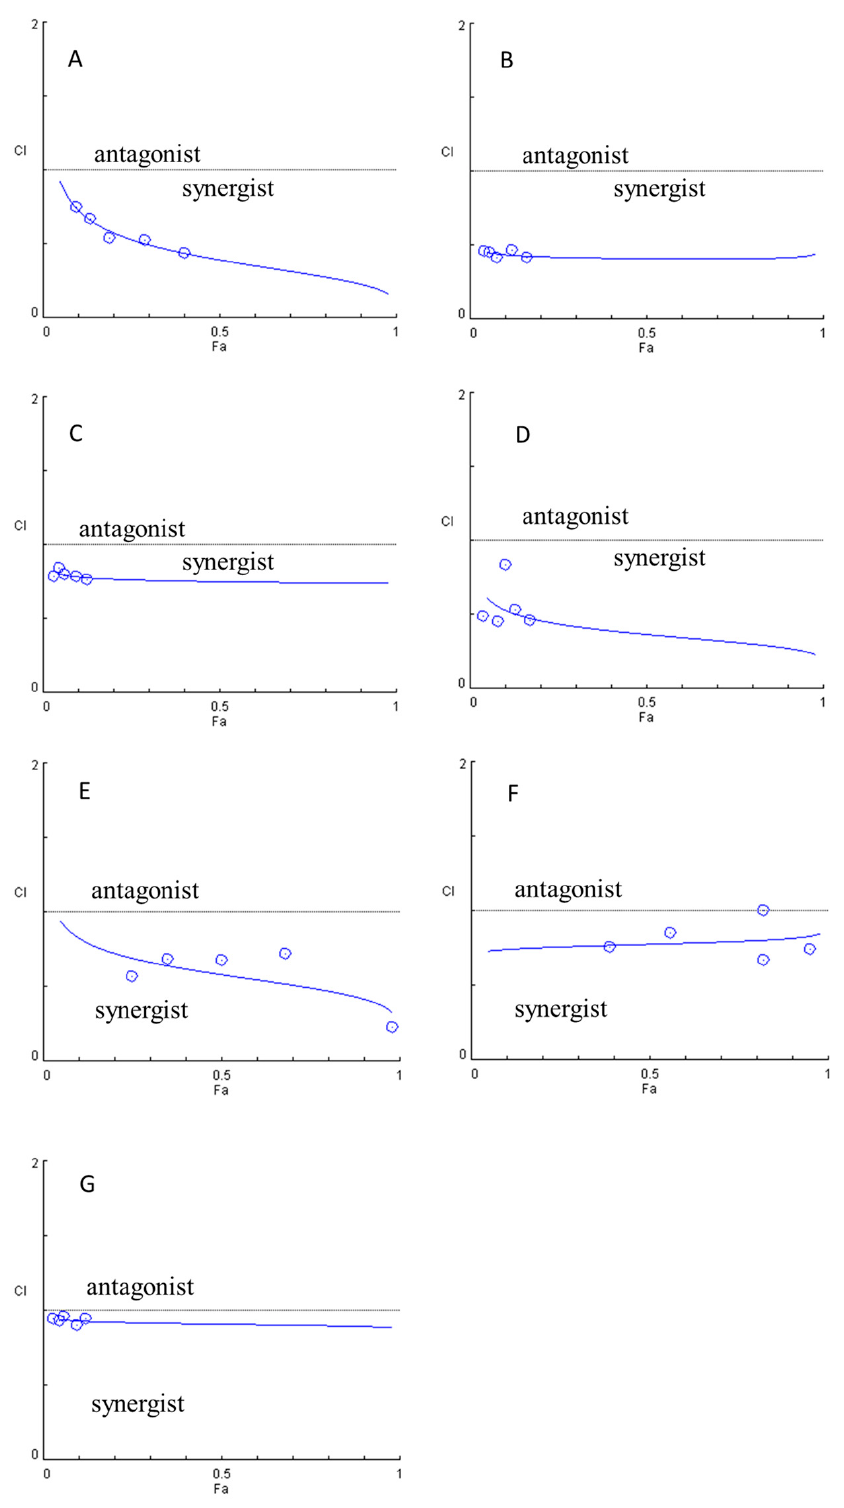
Figure 6. Screening of the synergistic effect of DFM (5–20 µ M) at constant ratio of 2.0 by combining HED, NHE, HET, ERI, and NER, with each one at the following concentrations: 1.0–4.0 µ M. The simulated lines were generated from CompuSyn by plotting CI versus Fa values. ( A ) ROS, ( B ) TBARS, ( C ) GSH/GSSG, ( D ) protein carbonyl, ( E ) COX-1, ( F ) COX-2, and ( G ) PGE2. The synergistic e ff ect of the constant ratio of the tested concentrations of HED, NHE, HET, ERI, and NER was analyzed by CompuSyn software, which generates computerized simulation data from various concentrations and fractions of e ff ect (Fa). The simulated data were simpli fi ed as a combination index plot (CI-Fa, Figure 6A–G). The synergistic e ff ect of DFM was detected at every concentration point tested in each experimental